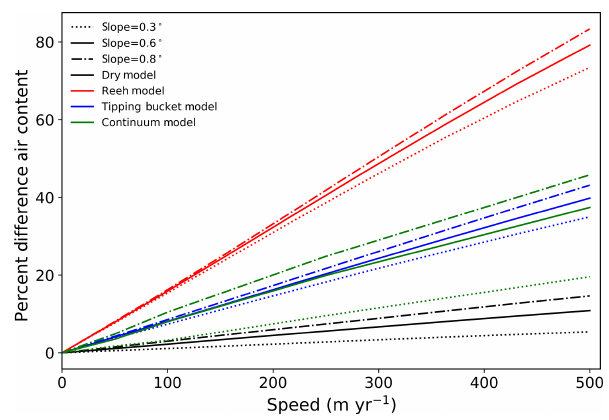
Figure 2. Example sensitivity test. Modeled differences between 1D and 2D for ice speed using a dry-firn model (black), Reeh model (red), tipping-bucket model (blue), and continuum model (green). Base accumulation is 0.5ma − 1 , approximately the average value of the EGIG transect shown in Fig. 1. Each simulation is run with surface slopes of 0.3 ◦ (dotted), 0.6 ◦ (solid), and 0.8 ◦ (dash-dotted) to represent different climate gradients that may exist around the